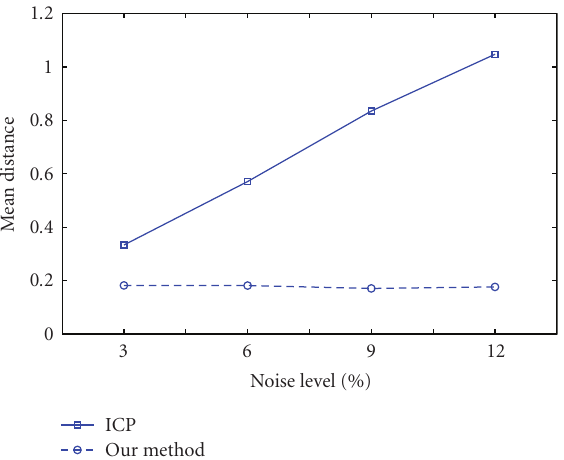
Figure 4: Comparison of mean distances between the reconstructed surface and measured data points for the 3D jar example at di ff erent noise levels using ICP and the proposed algorithm.